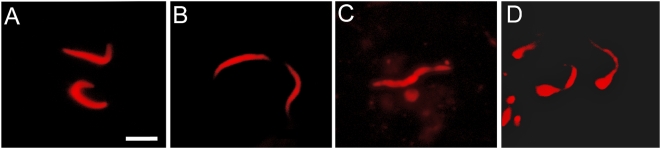
Confocal micrographs of remnant Plasmodium berghei sporozoites in the skin of control vs. immunized mice.A & B show typical presentation of sporozoites 2 and 4 h, respectively after mosquito inoculation into ear pinnae. C & D show typical presentation of sporozoites 2 and 4 h, respectively, after mosquito inoculation into ear pinna of actively immunized mice. Bar = 5 µm.